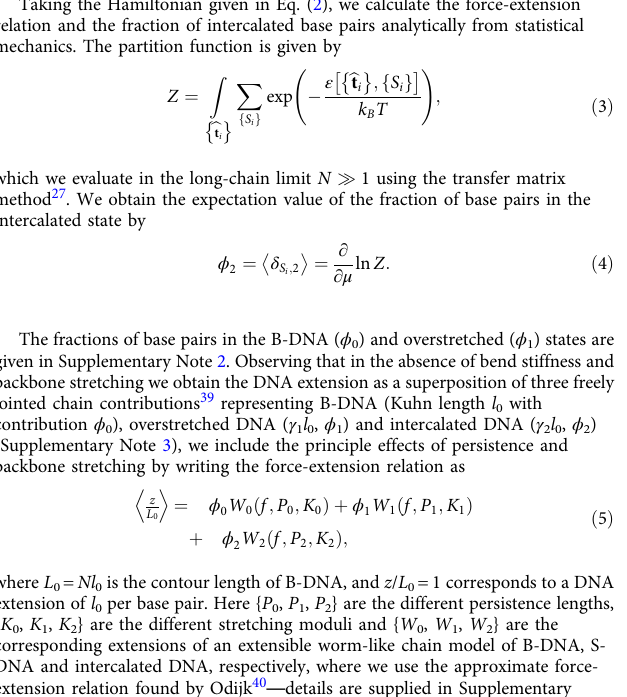
Taking the Hamiltonian given in Eq. (2), we calculate the force-extension relation and the fraction of intercalated base pairs analytically from statistical mechanics. The partition function is given by